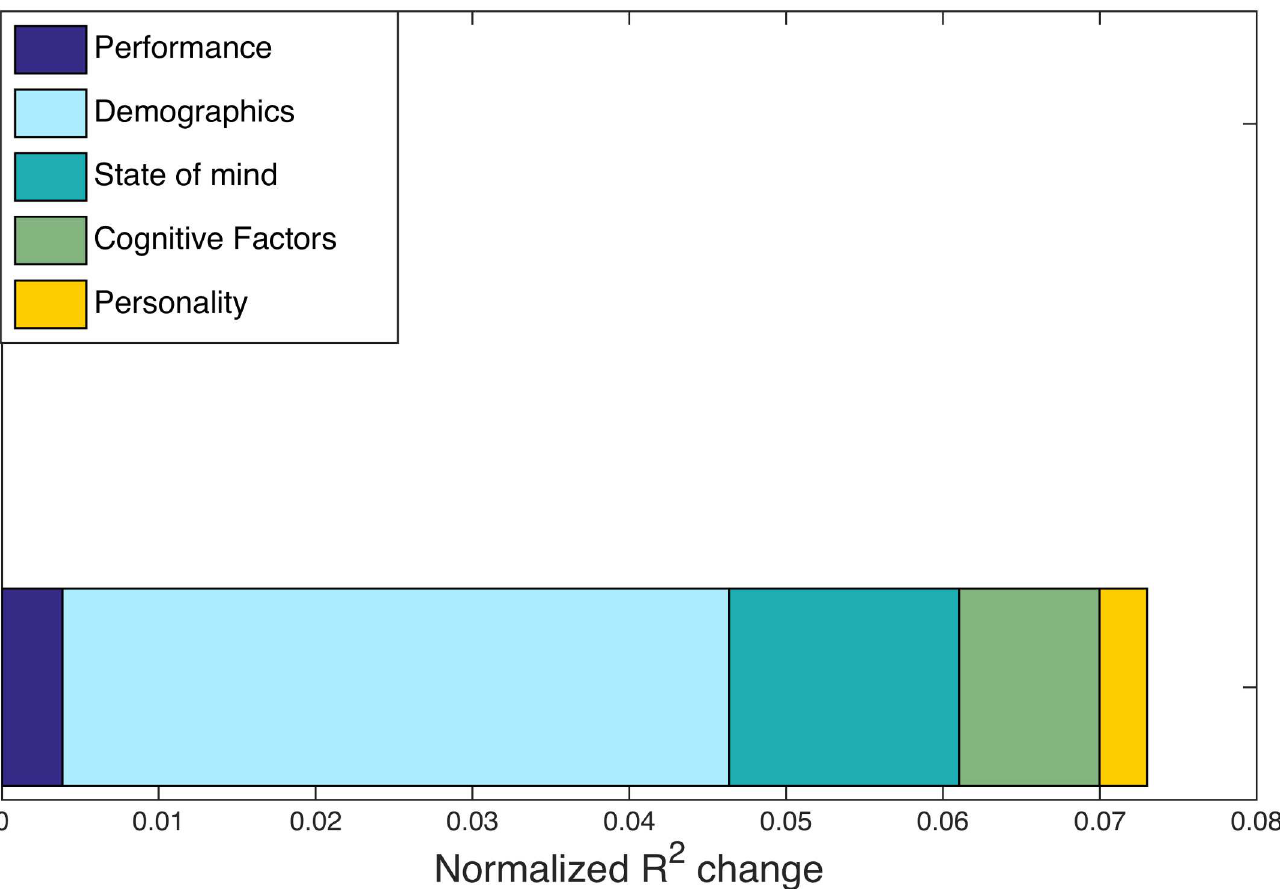
Fig 6. Multi-task R 2 changes. Normalized R 2 changes with respect to hypergraph cardinalityare shown for individualsin the multi-task study. R 2 changes are calculated from the regressionprocedure outlined in Methods, with five distinct categoriescommon to the multi-task and age-memory studies. The largest normalized R 2 change is from the demographics factor, but no factors exhibit a signficant correspondence with hypergraph cardinality.